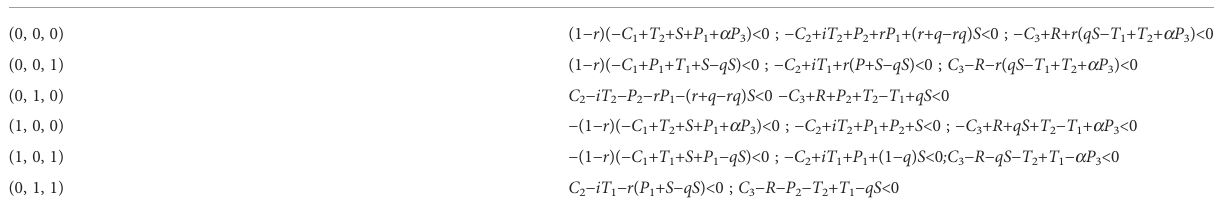
TABLE 4 Stability conditions of equilibrium points in the evolutionary game. ESS Stability condition